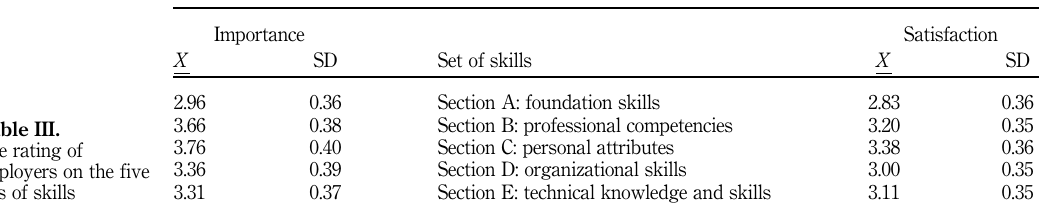
Table III. The rating of employers on the five sets of